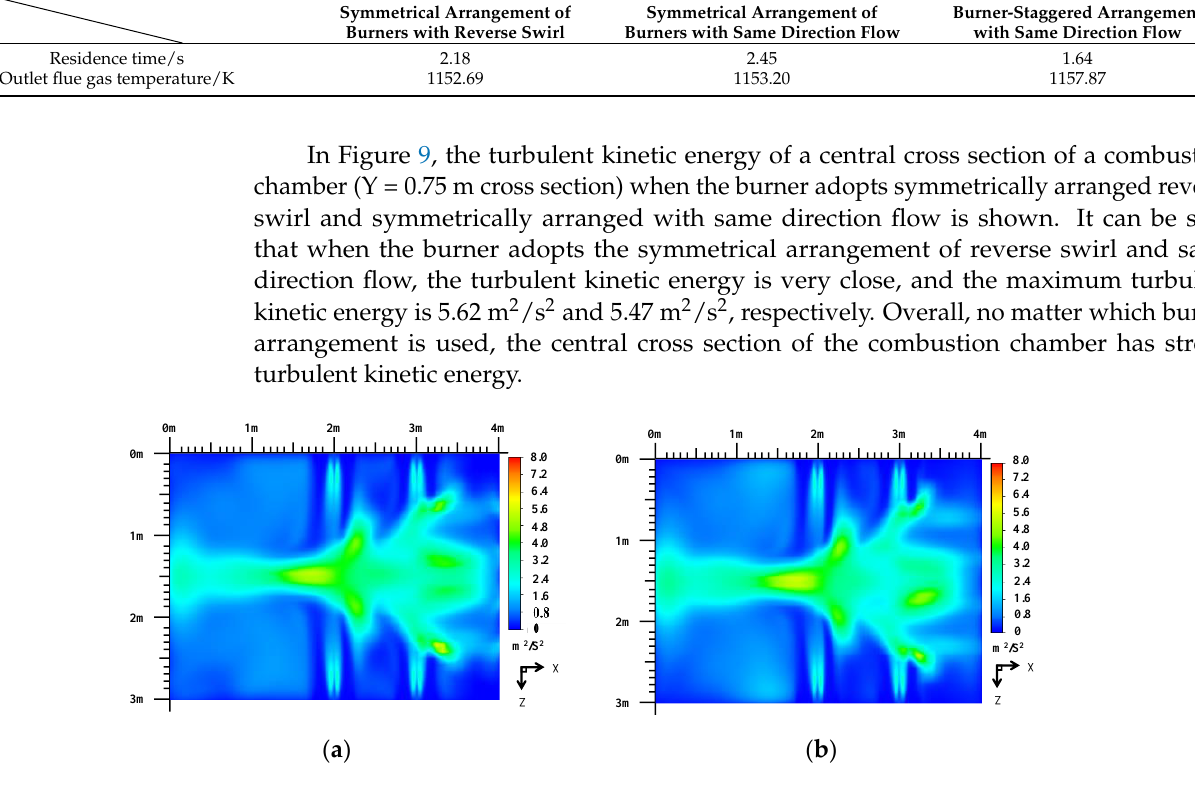
Table 2. Flue gas residence time and outlet flue gas temperature meter under different arrangement modes of burner.